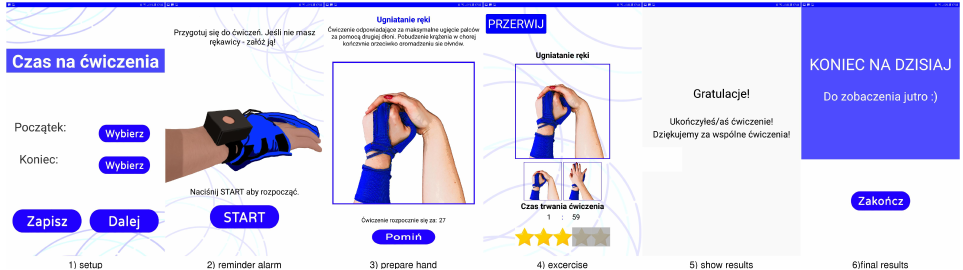
Figure 8. List of screens displayed on the